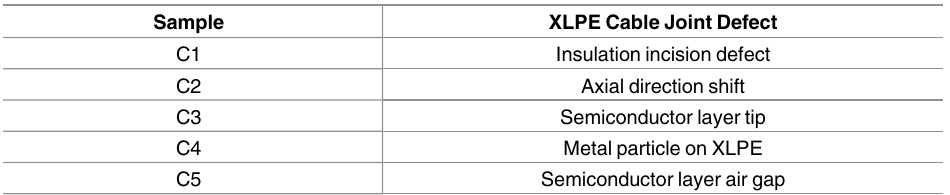
Table 1. XLPE cable joint defect